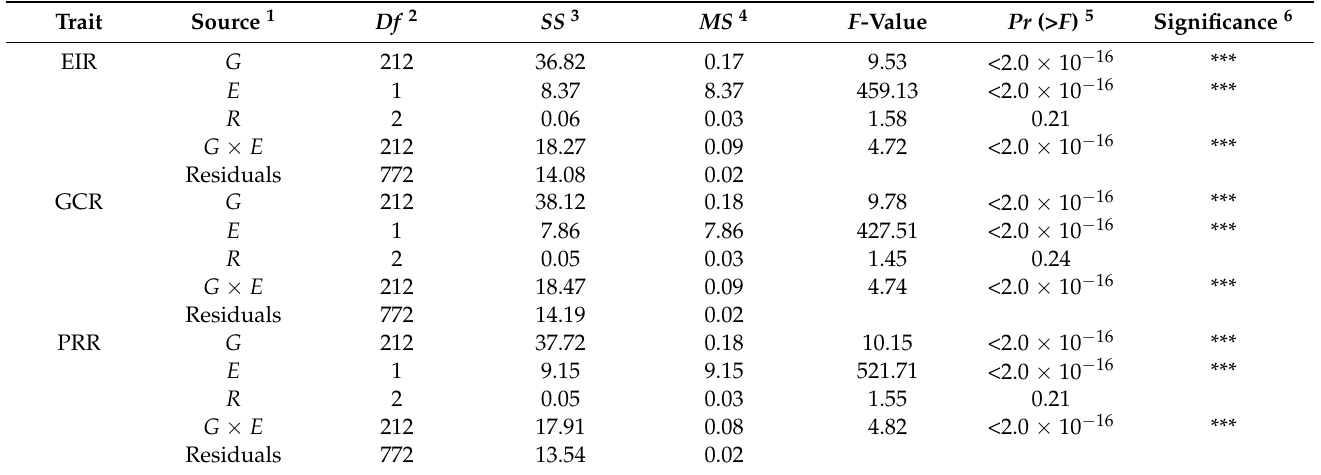
Table 2. Analysis of variance for the EIR, GCR and